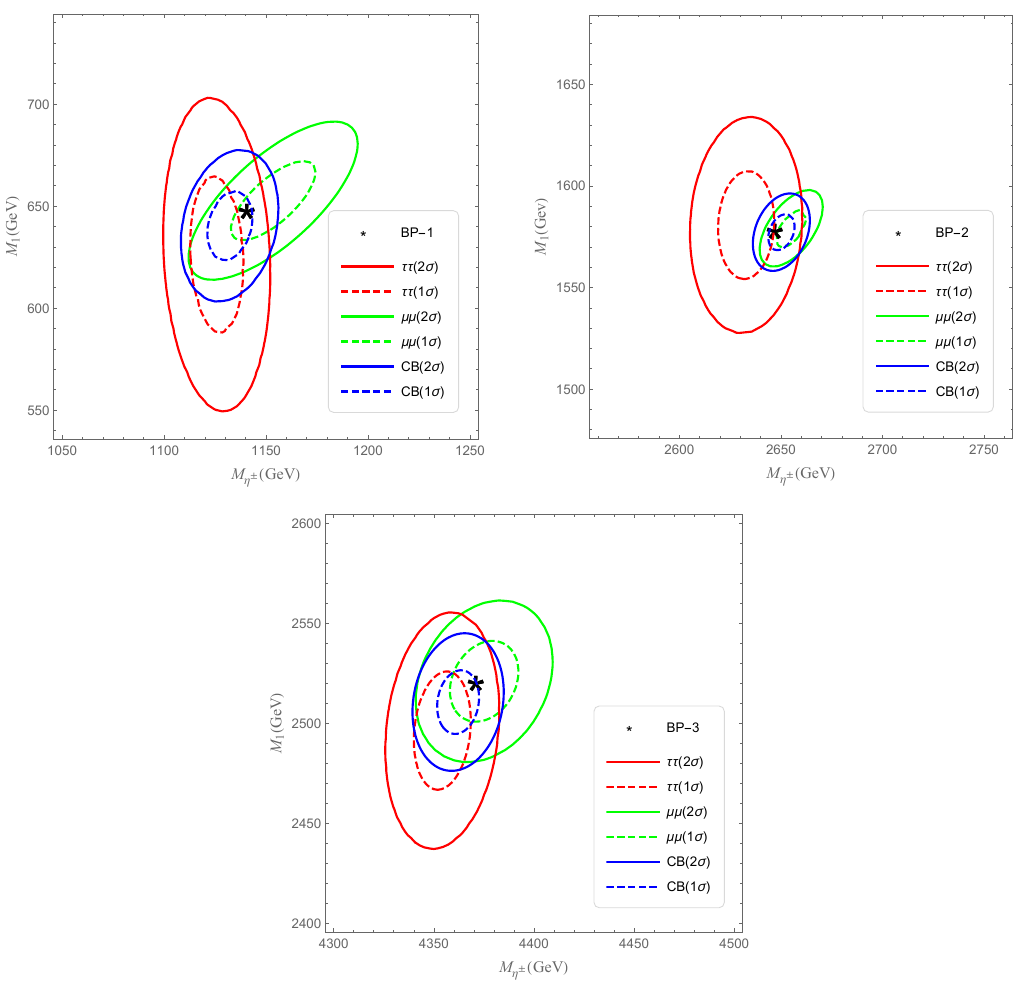
Figure 14 . The fitted results of the benchmark points in the M − M 1 plane for both µ + µ − + (cid:0) E T η ± and τ + τ − + (cid:0) E T channel. Here, we assume an integrated luminosity of 200 fb − 1 . The red and green lines are the results of τ + τ − + (cid:0) E T and µ + µ − + (cid:0) E T channel. The blue lines are the combined (denoted as CB) results of the dimuon and ditau channel. The dashed and solid lines correspond to the 1 σ and 2 σ range. The stars ? are the actual values for the benchmark